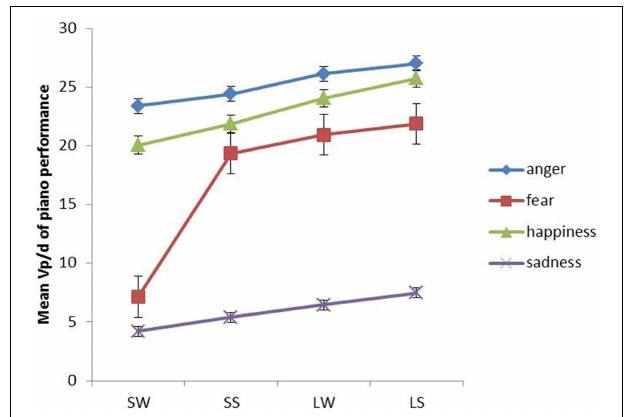
FIGURE 5 | The interaction between emotions and fingerings in terms ofVp/d in piano performance. Error bars represent the standard error of the mean.